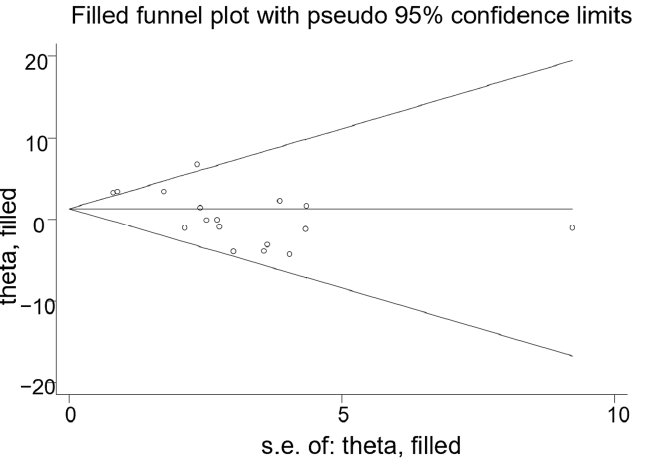
Figure 6. Filled funnel plot of effect estimate by standard error in means for HDL-C. The dots in the funnel plot represent the studies that were included. The larger the sample size, the smaller the standard error and the higher the distribution. Conversely, the smaller the sample size, the larger the standard error and the higher the distribution.